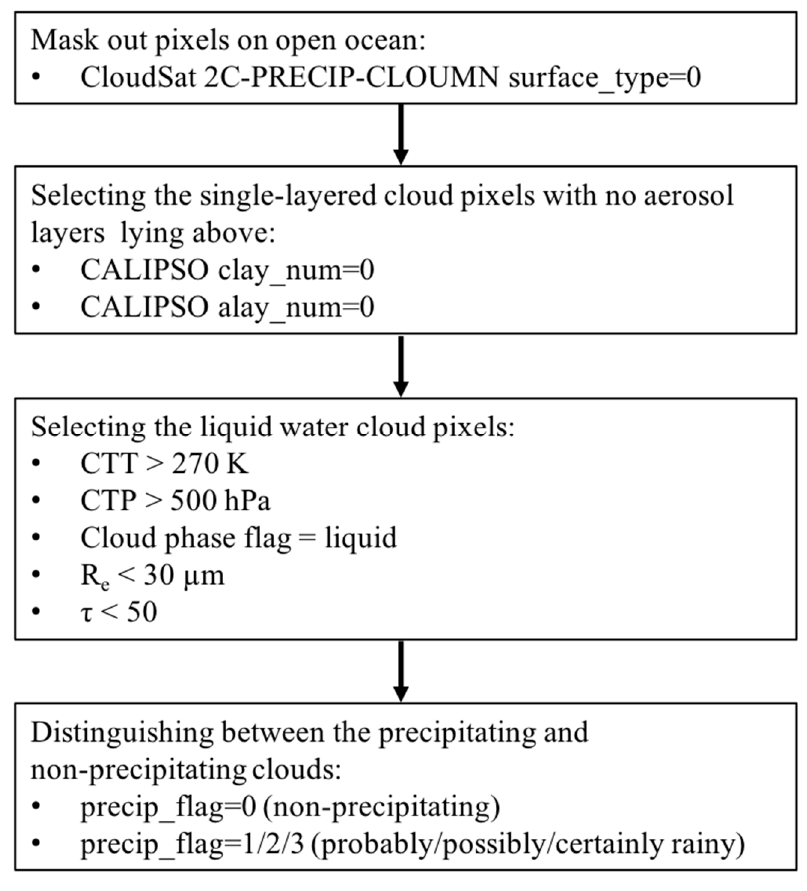
Figure 2. The processes of selecting marine warm cloud pixels over East Asia.